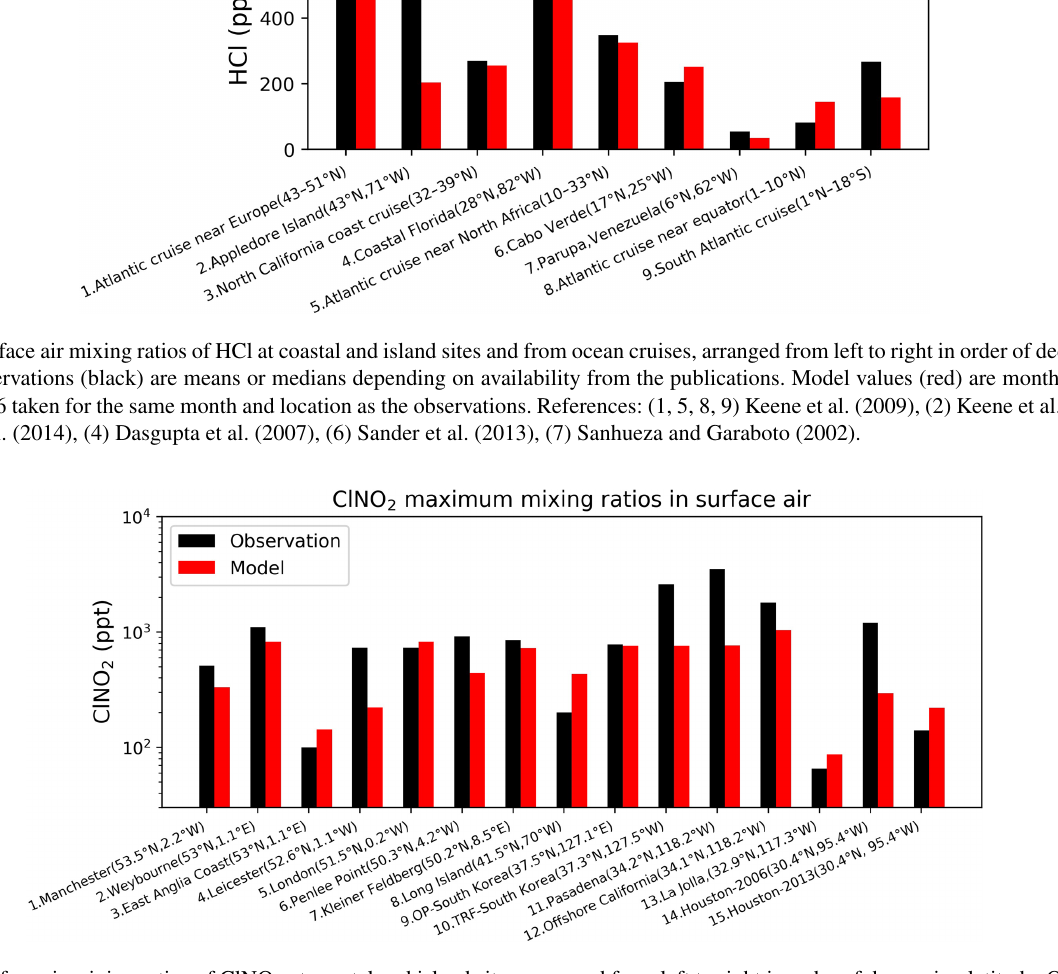
Figure 8. Surface air mixing ratios of ClNO 2 at coastal and island sites, arranged from left to right in order of decreasing latitude. Observed (black) and modeled (red) values are maxima for the reporting period. Model maxima are based on hourly values sampled at the same location and time period as the observations. References: (1) Priestley et al. (2018), (2, 4, 6) Sommariva et al. (2018), (3, 5) Bannan et al. (2017), (7) Phillips et al. (2012), (8) Kercher et al. (2009), (9, 10) Jeong et al. (2018), (11) Mielke et al. (2013), (12) Riedel et al. (2013), (13) Kim et al. (2014), (14) Osthoff et al. (2008), (15) Faxon et al.